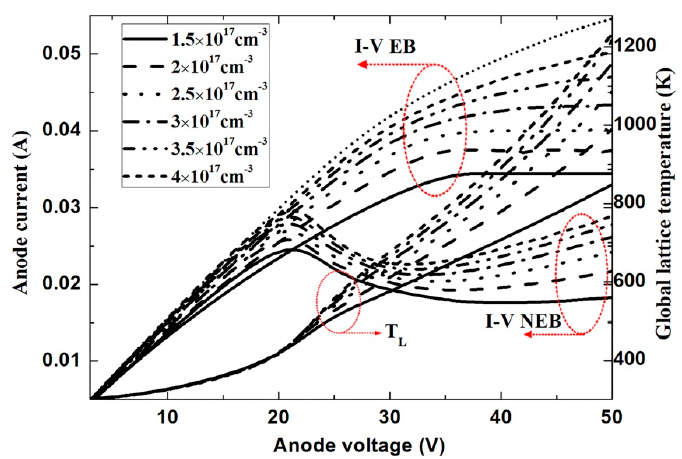
Figure 6. I–V characteristics of GaN Gunn diode under NEB model and EB model, and the global lattice temperature at different N ac under NEB model.